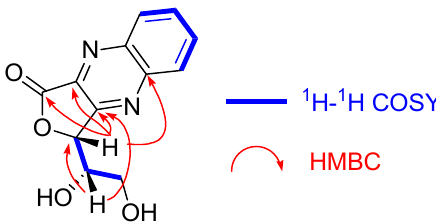
Figure 5. Selected 1 H– 1 H COSY and HMBC correlations of 8 .